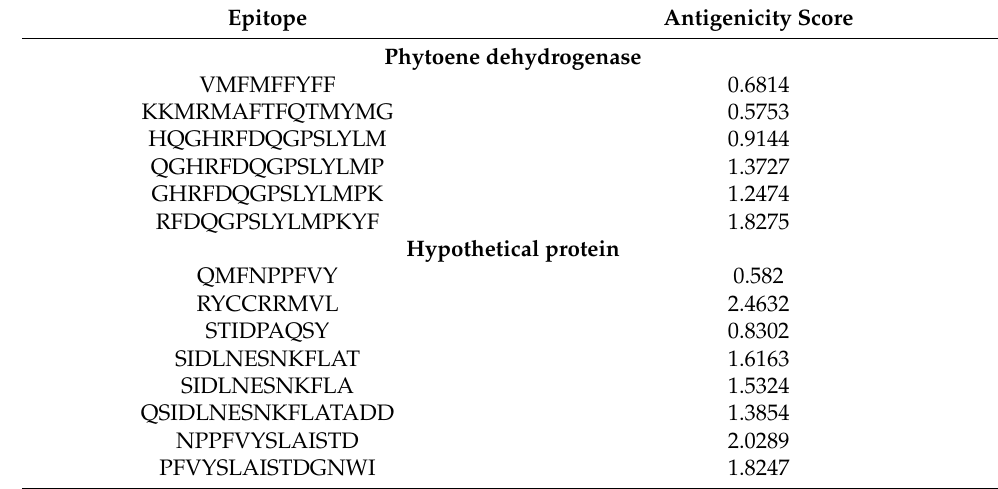
Table 4. Selected T-cell epitopes for vaccine construct and their antigenicity scores.